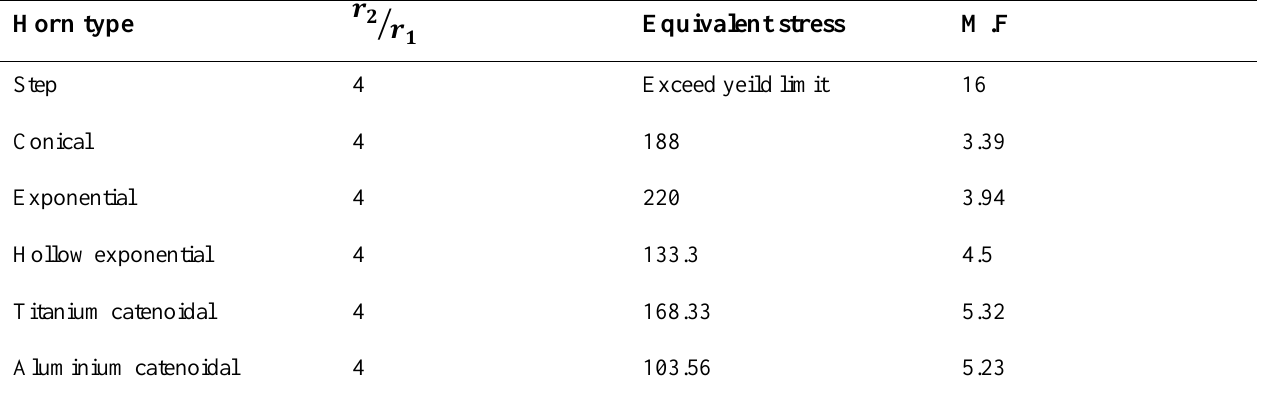
Table 2. Comparison of aluminium and titanium catenoidal horns with other horns [7, 10] Horn